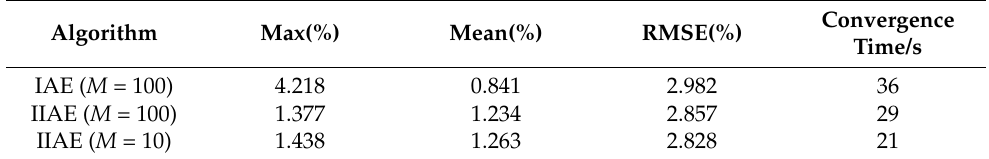
Figure 4. The SOC estimation results and errors based on the IAE algorithm under the CCD test: ( a ) the SOC estimation results at M = 100, ( b ) the SOC estimation results at M = 10, ( c ) the SOC error at M = 100, ( d ) the SOC error at M = 10. Table 4. SOC estimation errors analysis under different IAE